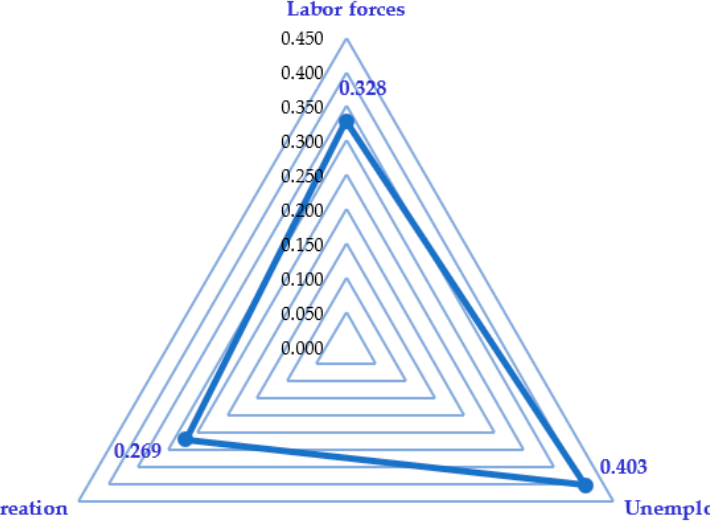
Figure 7. Relative weights of the assessment indicators for “Employment”.